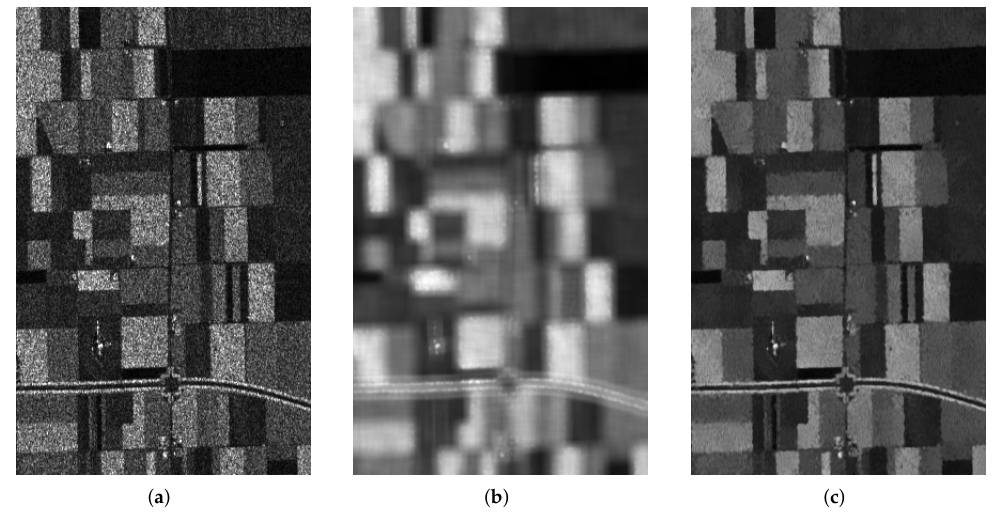
Figure 11. The first real SAR image and auxiliary images. ( a ) Original real SAR image; ( b ) The auxiliary image of LBNL_FCM; ( c ) The auxiliary image of